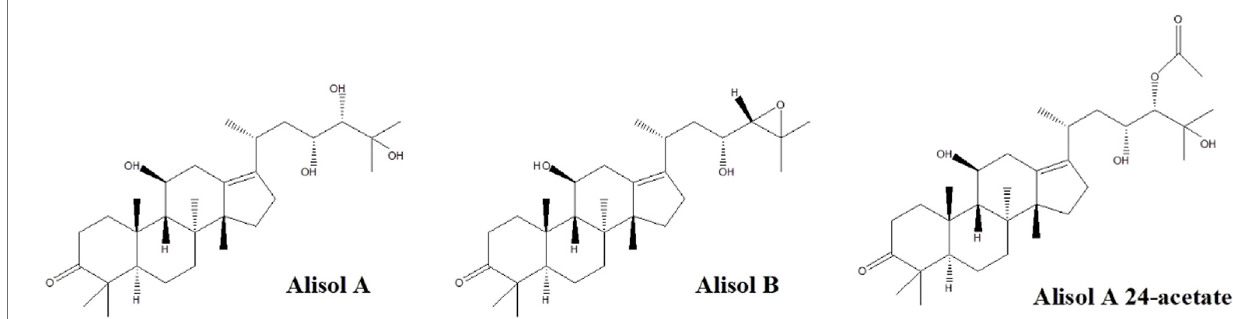
FIGURE 1 | Chemical structures of alisol A, alisol B, and alisol A 24-acetate.